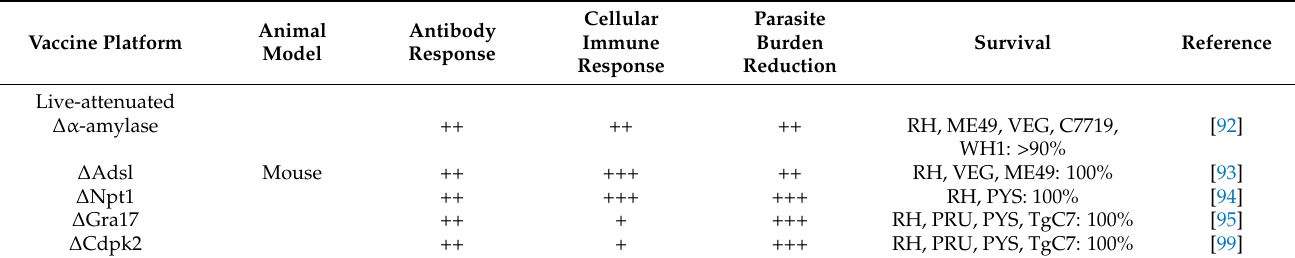
Table 4. An overview of the live-attenuated T. gondii vaccine platforms and their efficacies. Only the studies that assessed all four of the parameters listed below were selected and referenced in the table. Survival refers to the total duration of survival for immunized mice. +, weak; ++ intermediate; +++ strong. Vaccine Platform Survival Reference Live-attenuated ∆ α